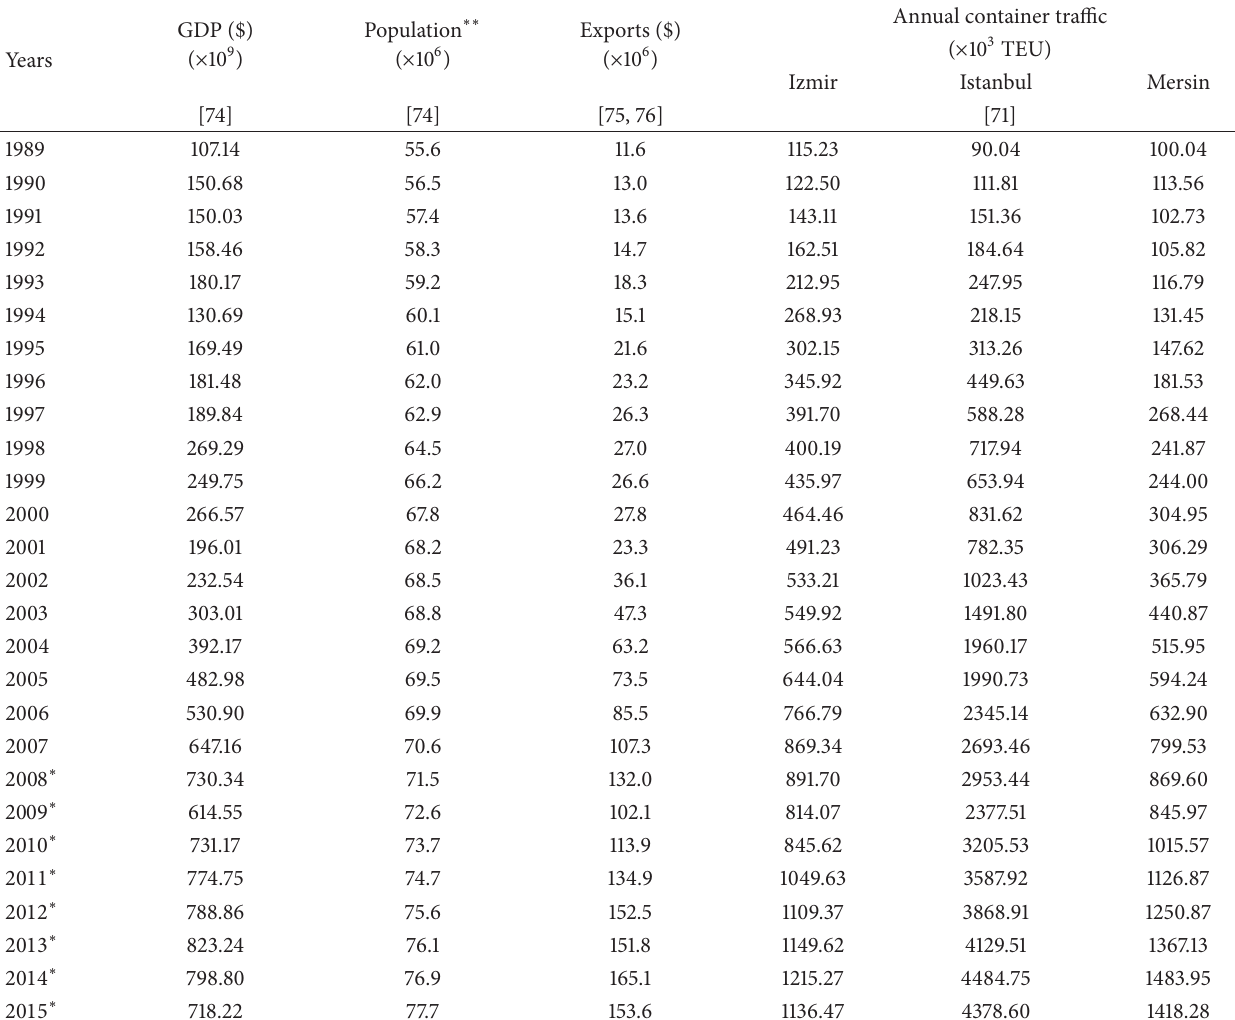
Table 2: Input and output variables used for forecasting